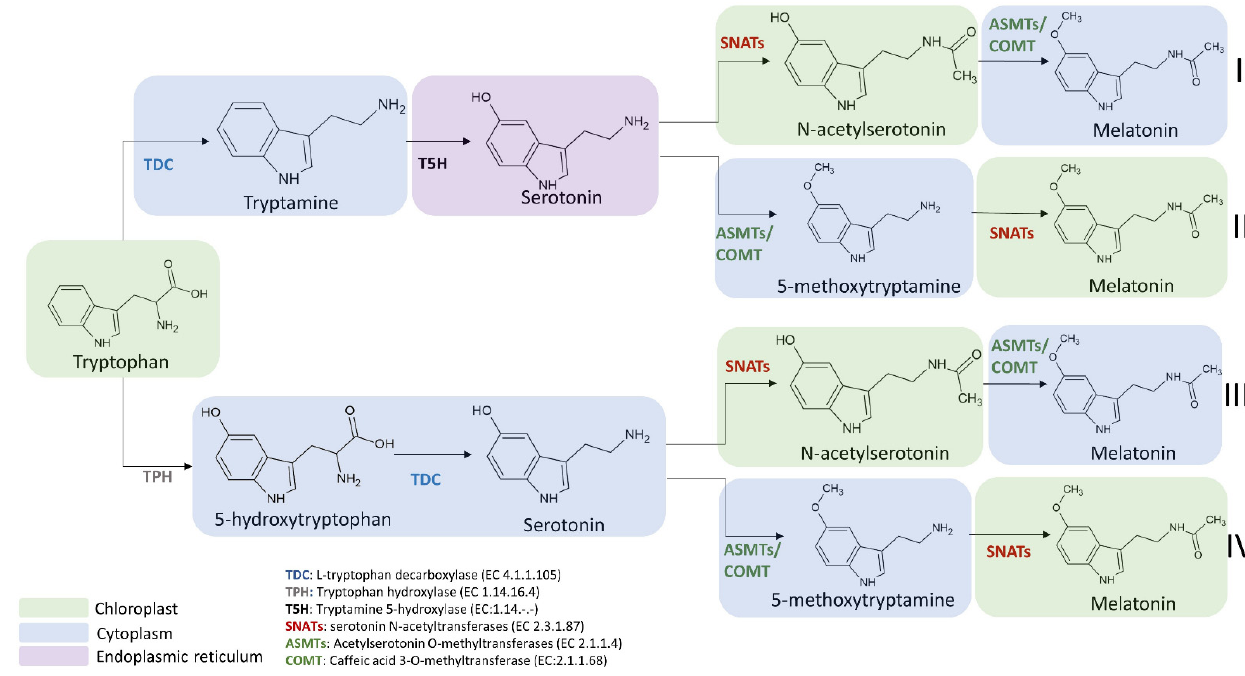
Figure 6. Subcellular localization of melatonin intermediates and enzymes involved in the transformation of tryptophan into melatonin in the different melatonin biosynthetic routes. TDC: L-tryptophan decarboxylase; TPH: tryptophan hydroxylase; T5H: tryptamine 5-hydroxylase; SNATs: serotonin N-acetyltransferase; ASMTs: acetylserotonin O-methyltransferase; COMT: caffeic acid 3-O-methyltransferase.